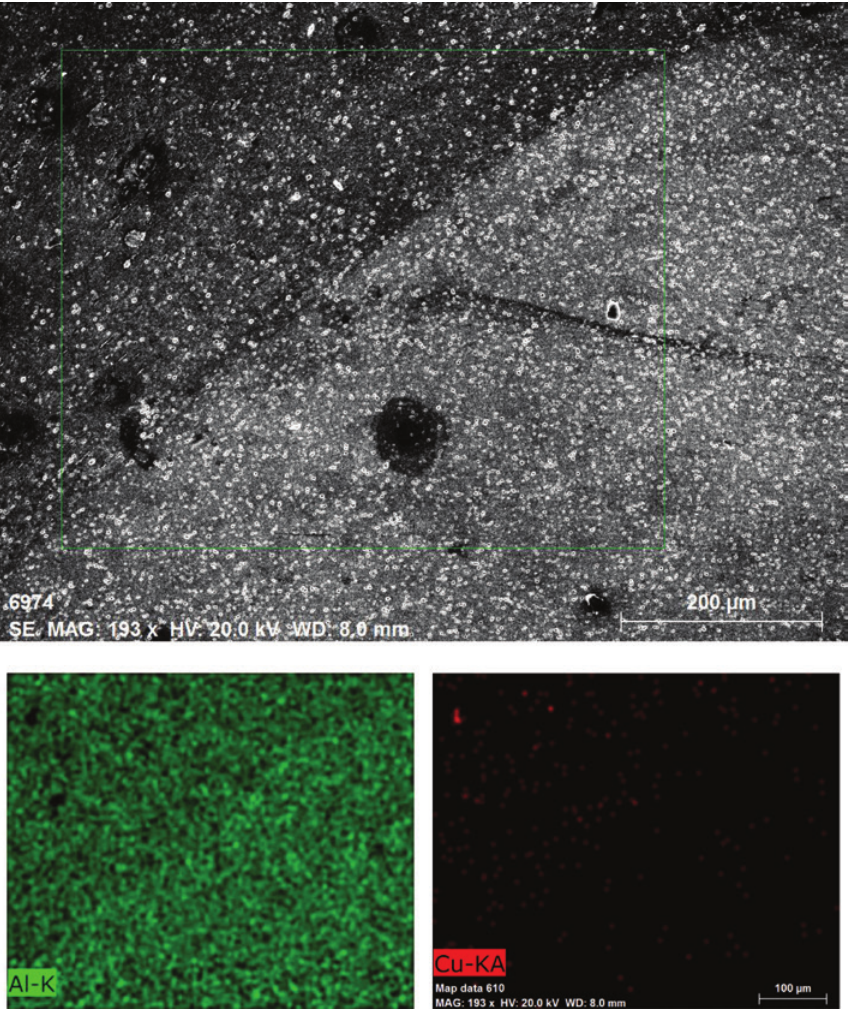
Figure 9: SEM backscattered electron image, the EDS, and the element mapping analysis on the retreating side of the stir